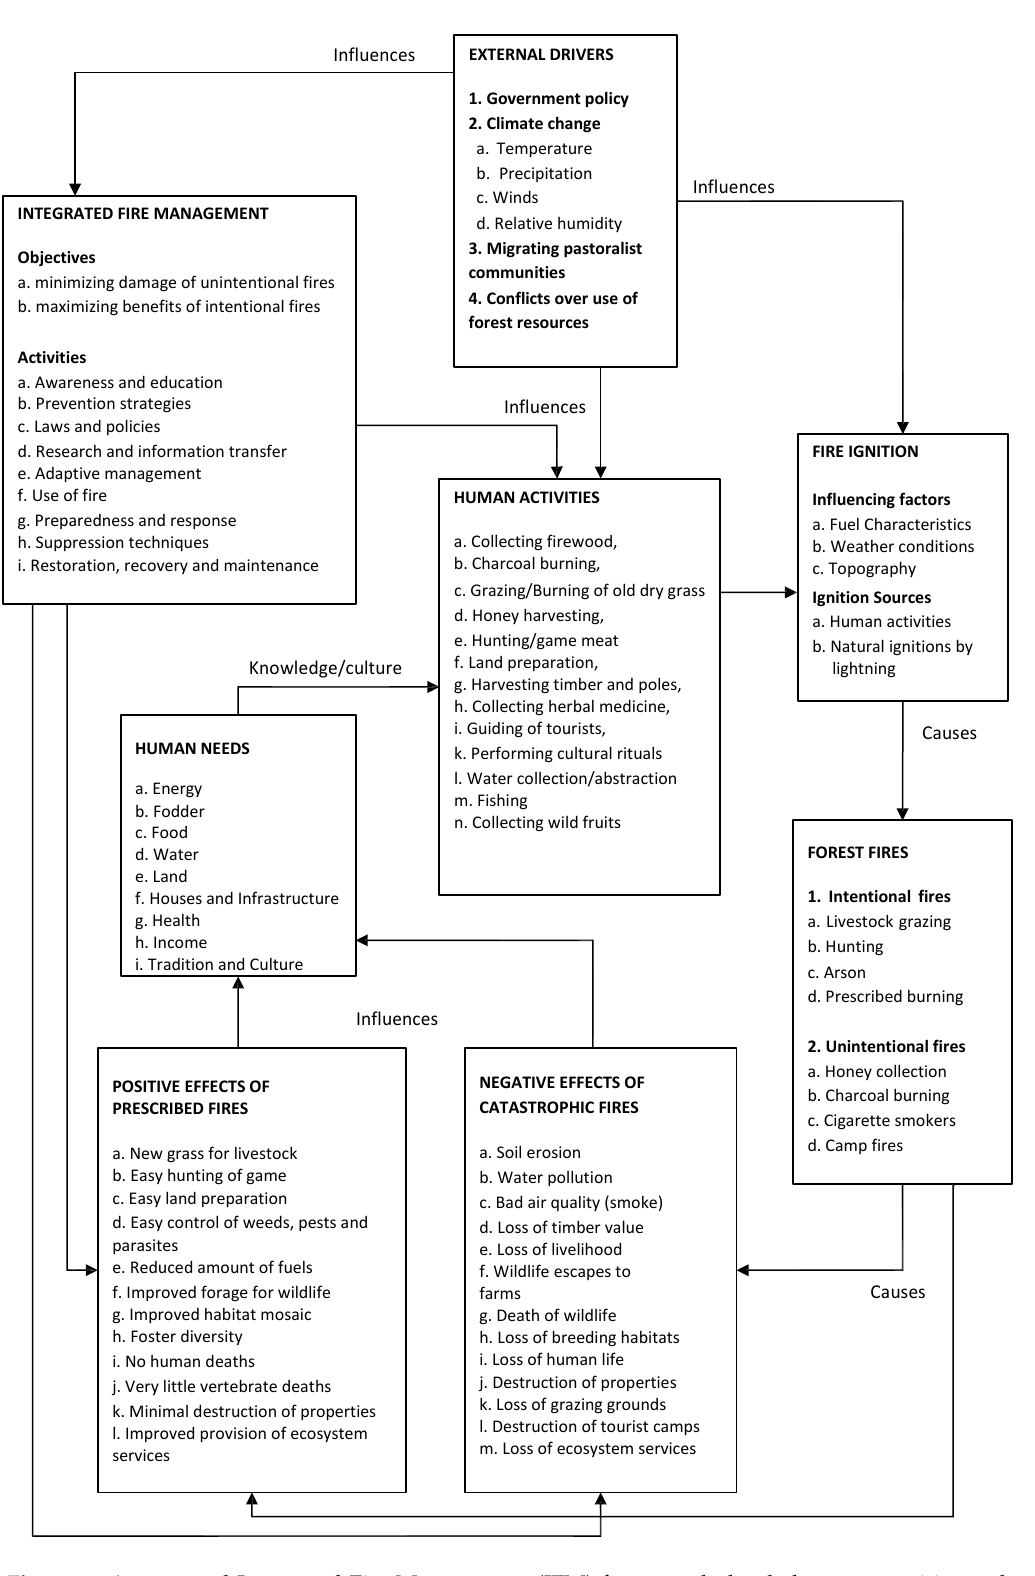
Figure 1. A proposed Integrated Fire Management (IFM) framework that helps communities and natural resource managers address both damaging and beneficial fires in